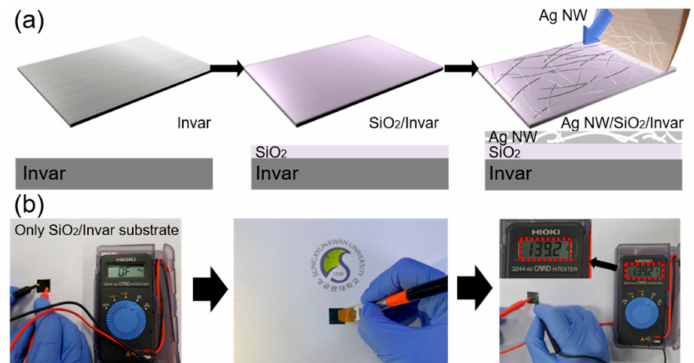
Figure 1. ( a ) Schematic fabrication processes of curved brush-painted Ag nanowires (NWs) / SiO 2 / invar sample using brush processing at room temperature. For insulating metal invar substrate, 2 µ m SiO 2 film was deposited on invar substrate using plasma enhanced chemical vapor deposition. ( b ) Pictures showing e ff ect of SiO 2 insulator layer and conductive Ag NW network on SiO 2 / invar